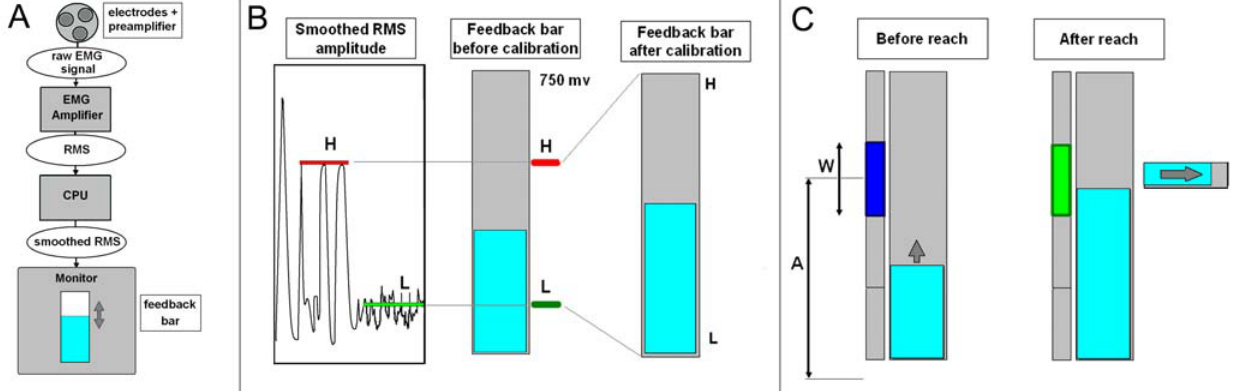
Figure 1. Experimental setup. a) Signal capture. Raw EMG signal filtered in the band 25–450 Hz, converted in RMS, sampled at 1 khz and smoothed by averaging in bins of 50 ms. Feedback bar: width 2 cm, maximal height 20 cm, distance from the eyes 60 6 10 cm, refresh rate 20Hz. b) Feedback calibration. Before calibration, the bar represents the voltage of the smoothed RMS signal in the range 0–750 ms. After calibration, the bar represents the signal normalized in the range L, H . c) Pointing task. Feedback bar represented before- and after the reach in the sustained modality. A, W : amplitude and width of the target. For normalization, we considered that L was at distance W/2 from the rest level, i.e., for target k, A= W/2 + (k 2 1)W + W/2=kW . Horizontal progress bar: time elapsed in the target.